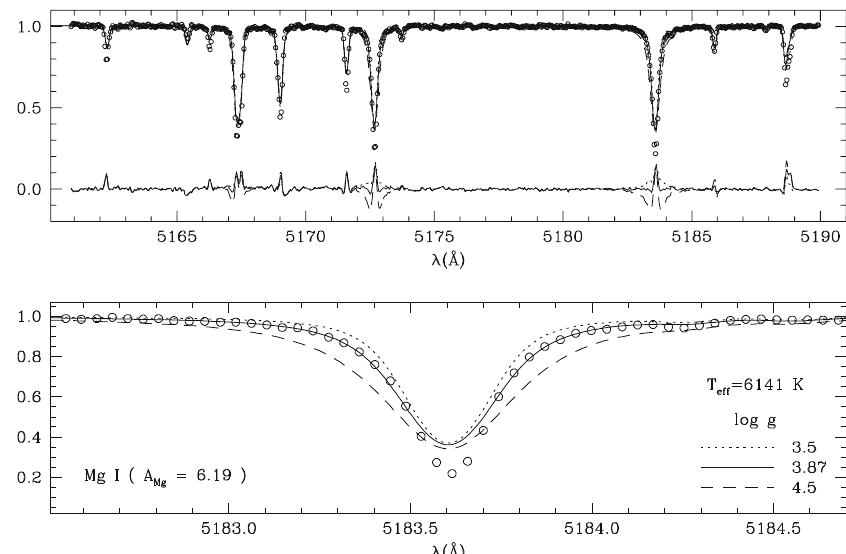
Fig.7 The toppanel showspartofthespectrumofthemetal-poorstarBD+174708,whilethe bottompanel provides a close view of one of the Mg i b lines in the spectrum of the star compared with calculations for models with a range in surface gravity. The analysis focuses on the wings, since the line core is not matched due to departures from LTE. Image reproduced with permission from Ramírez et al. (2006), copyright by ESO